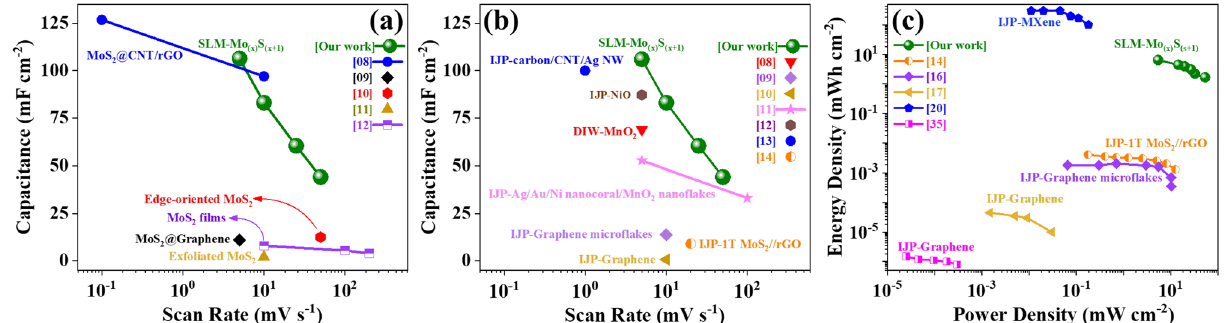
Figure 5. (a) Areal rate capacitance for different MoS 2 -based structures processed by various conventional methods for energy storage devices (the weight percentage in parenthesis indicates the amount of MoS 2 in the structure); (b) areal rate capacitance for different materials processed with various 3D printing methods for energy storage applications and (c) Ragone plot comparing the areal power density versus areal energy density of 3D-printed electrodes intended for energy storage